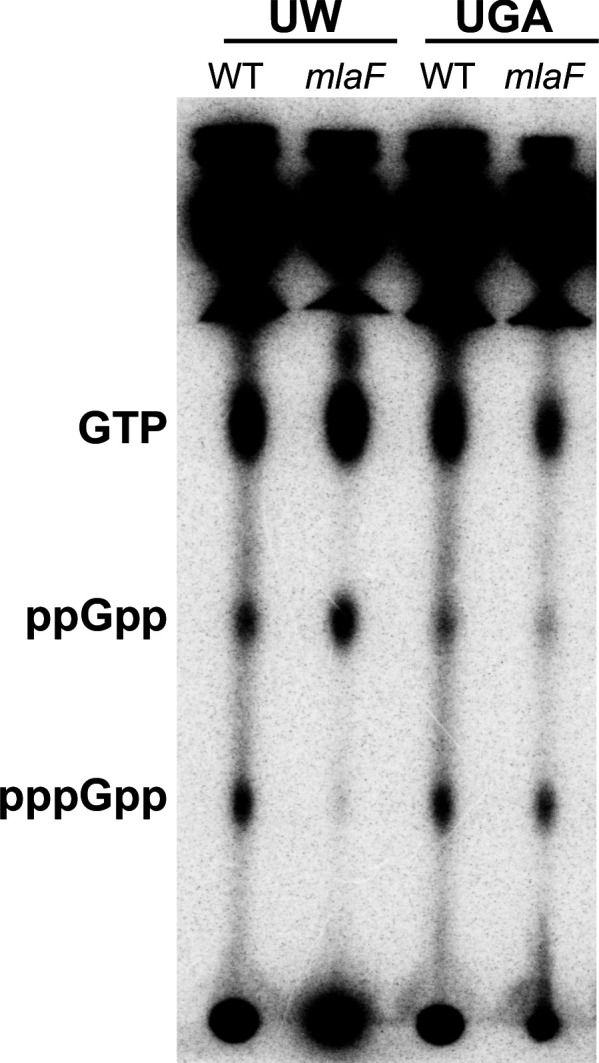
UW ΔmlaF mutant accumulates ppGpp.(A) Representative TLC of 32Pi-labeled nucleotides extracted from whole cells separated on PEI-cellulose plates in 1.5 M KH2PO4 mobile phase. Positions of GTP, ppGpp, and pppGpp are denoted on the left. The image shown here is representative of three biological replicates. Additional replicate images are shown in Figure 5—figure supplement 1.